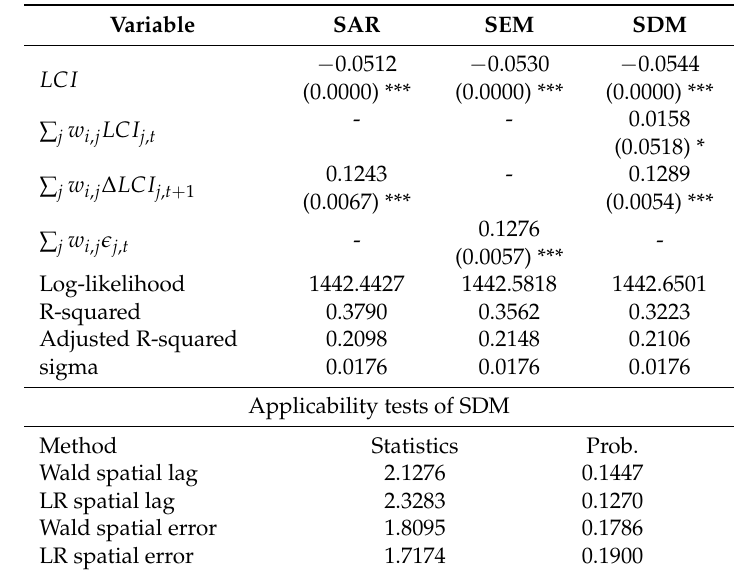
Table 8. Estimation results of absolute convergence of carbon intensity ( p -values in